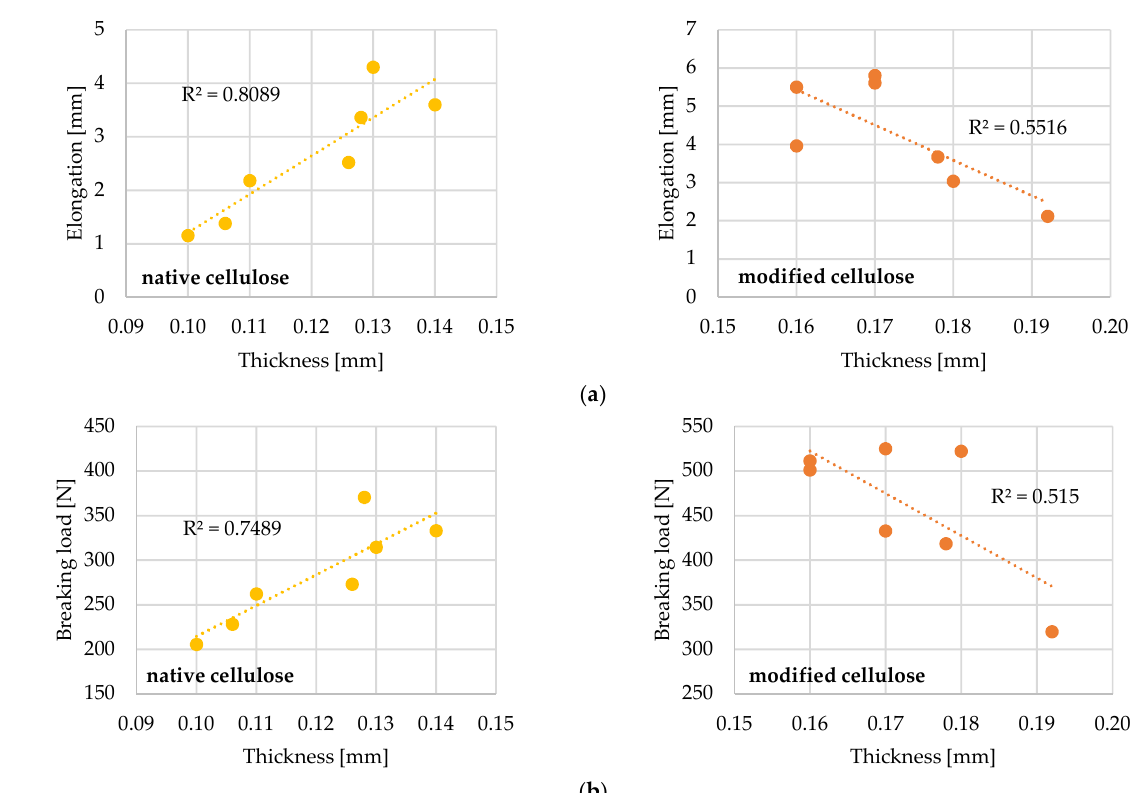
Figure 1. Correlation relationships between the mechanical properties of cellulose and the thickness of the polymer: ( a ) elongation and ( b ) breaking load.